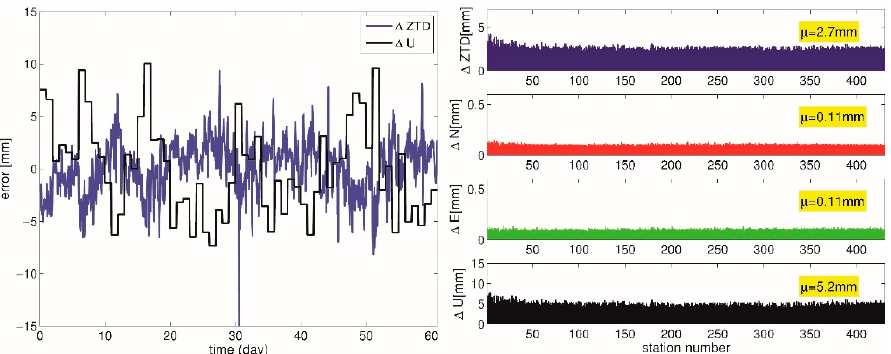
Figure 3. Results for the second simulation experiment. Left panel: the error in the ZTD and the error in the station up-component for the POTS station as a function of time. Right panel: the station- specific RMSE for the ZTD (top), the gradient components (middle), and the station up-component (bottom). The number with yellow background corresponds to the averaged RMSE of the respective parameter.